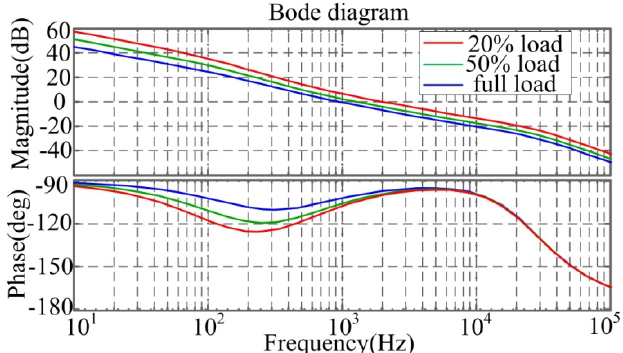
Figure 20. Frequency response of T ( s ) under different load conditions.